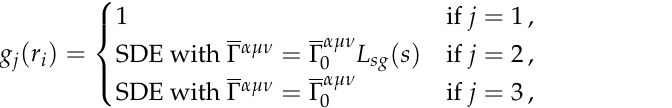
computed from Equation j